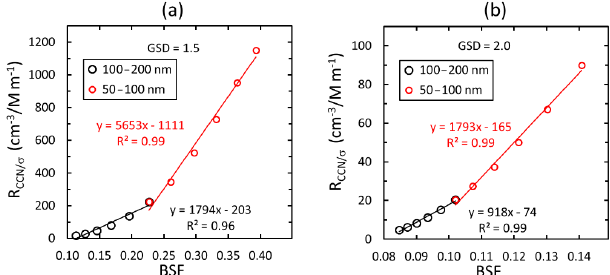
Figure 10. Linear regressions of R CCN /σ vs. backscatter fraction BSF ( λ = 550nm) of simulated unimodal (a) narrow (GSD = 1 . 5) and (b) wide (GSD = 2 . 0) size distributions. The regressions were calculated assuming that the data consist of size distributions with GMD ranging from 50 to 100 and 100 to 200nm. R CCN /σ was calculated assuming particles larger than 90nm get activated.